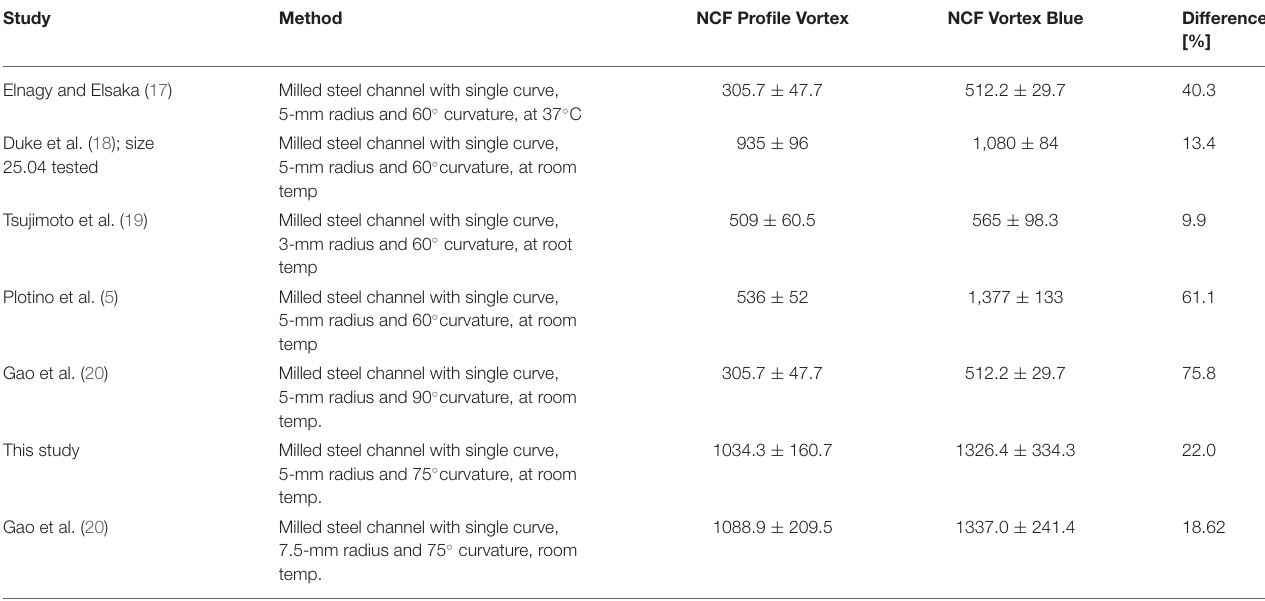
TABLE 3 | Selected data of publications that directly compared Profile Vortex and Vortex Blue instruments regarding their cyclic fatigue resistance.